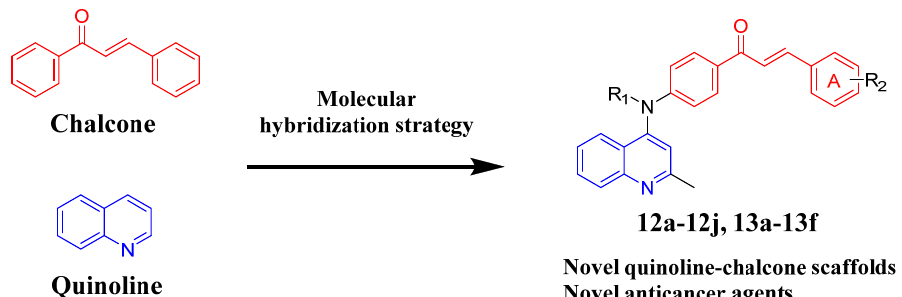
Figure 3. Design of novel quinoline-chalcone derivatives as anticancer agents.